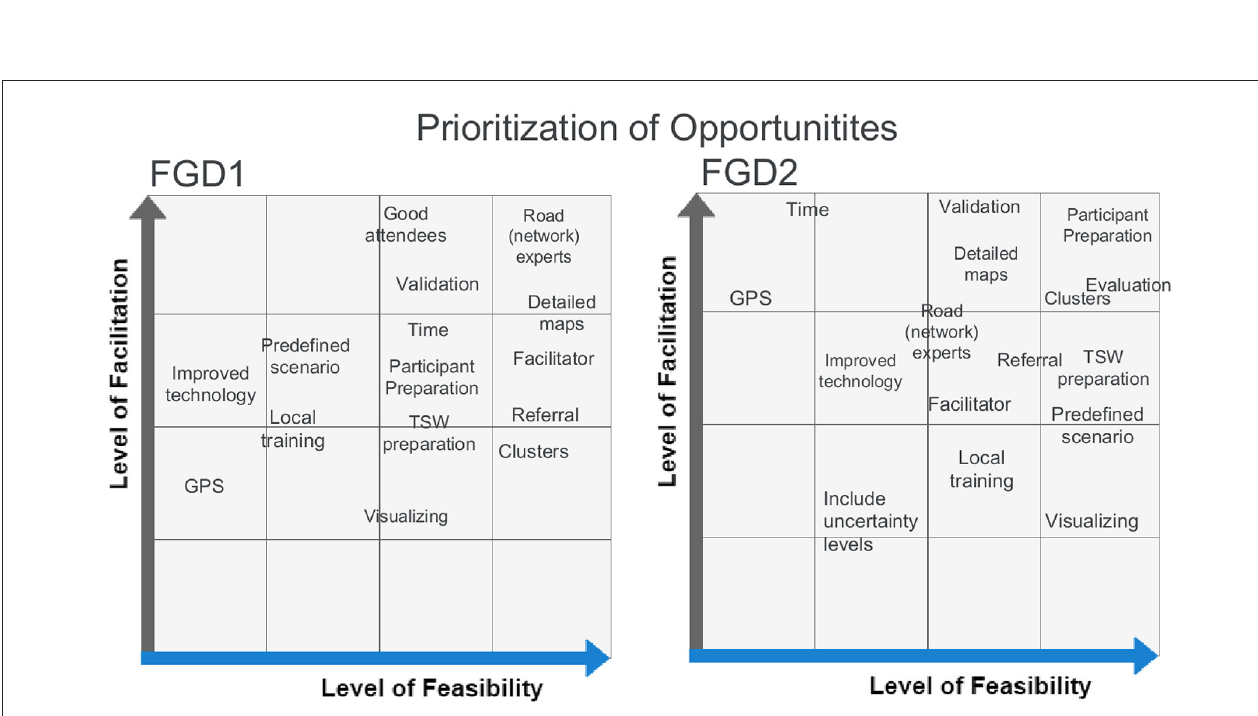
FIGURE7 Facilitation-feasibility grid for the prioritization of identified opportunities. The left grid shows the results for focus group 1 while the right grid shows the results of focus group 2. Each identified opportunity is ranked according to the mutually agreed level of facilitation and